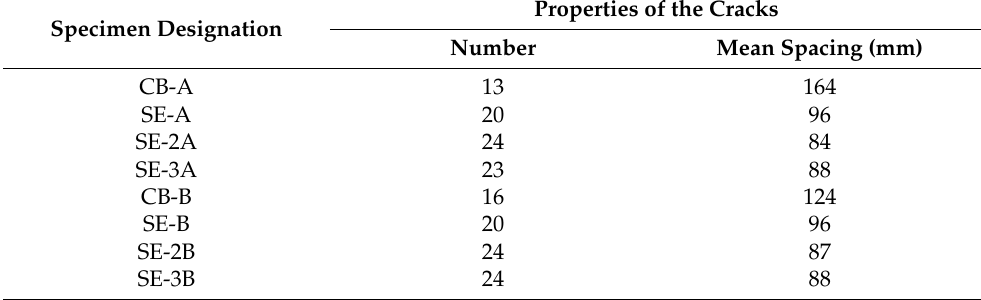
Table 4. Summary of indices.